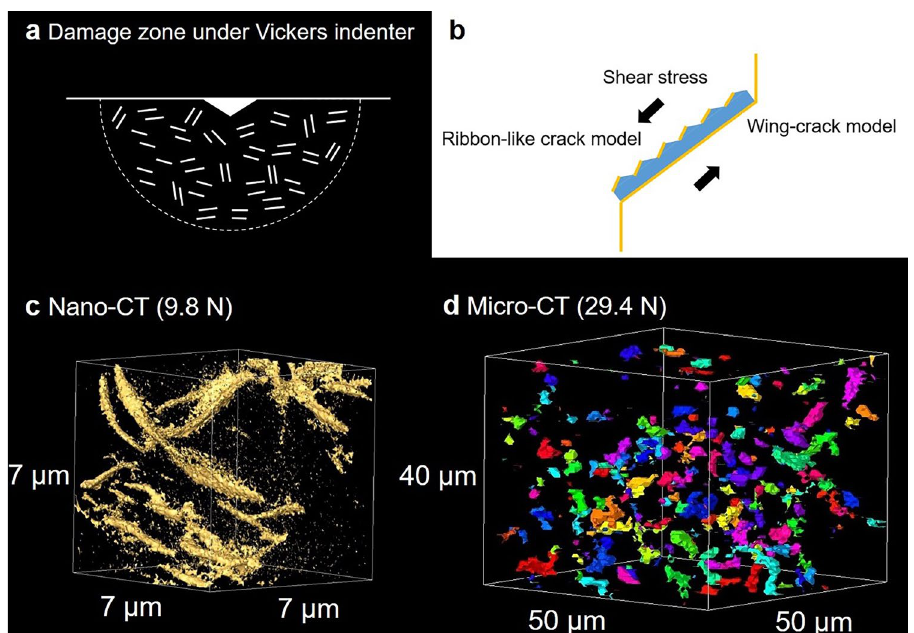
Figure 8. Ribbon-like crack/wing-crack models in the microcrack zone. ( a ) Damage zone under Vickers indenter, ( b ) formation of ribbon-like cracks on the modulated surface and that of wing-cracks on both sides of a flat surface of an individual plate-like crystal, ( c ) nano-CT image of the microcrack zone induced by Vickers indentation at 9.8 N, ( d ) micro-CT image of the microcrack zone induced by Vickers indentation at 29.4 N. Some rod-like defects are